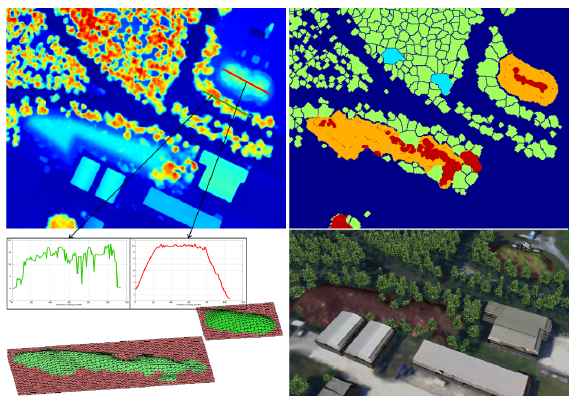
Figure 2: Detection and reconstruction of hills. Top left: Part of the DSM. Top right: Results of the tree detection by W (green) and H upon the hills (red) in the corresponding part. The com- ponents recognized and non-recognized as hills are marked in or- ange and cyan color, respectively. Bottom left: Anomalies in the DTM are reconstructed (red and green triangles) and mod- eled (green triangles). Bottom right: A view of the urban ter- rain model, with building models computed with the procedure of (Bulatov et al., 2014), hills, and tree